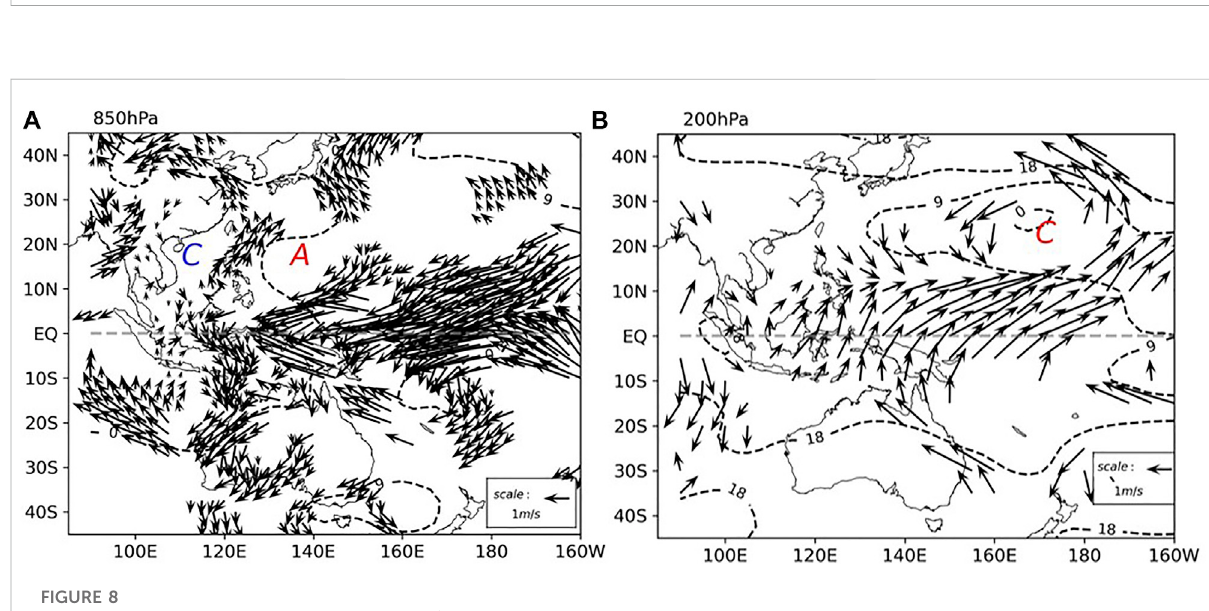
Composite anomalies of wind (vectors, units: m s − 1 ) and geopotential height (black dotted line, unit: m) at (A) 850-hPa and (B) 200-hPa. The arrow areas indicate the values are statistically signi fi cant at the 90% con fi dence level. The letter A and C indicates for anticyclonic and cyclonic circulation,